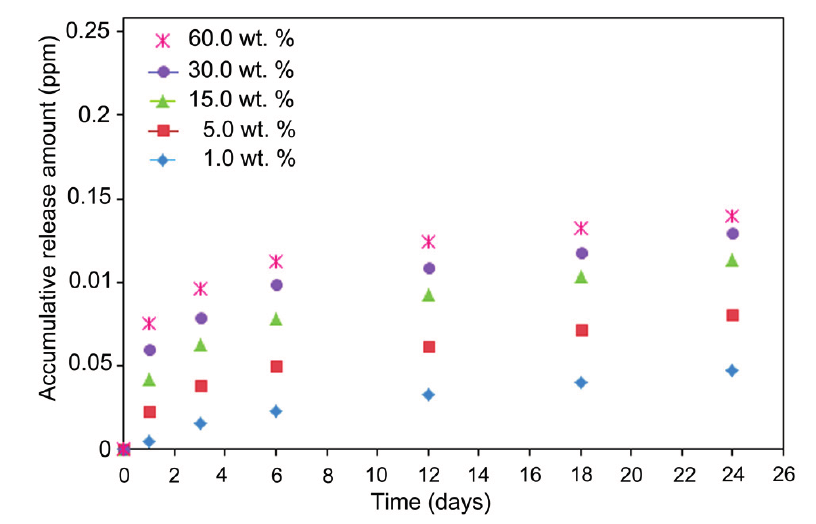
Figure 9. Fe +3 and Fe +2 release curves of ORS/Fe 3 O 4 /PCL-NCs in PBS (pH = 7.00) with 1.0, 5.0, 15.0, 30.0 and 60.0 wt. %,